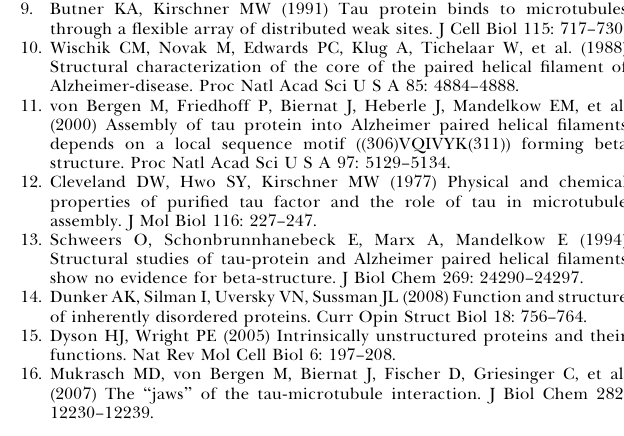
Figure S1. Degeneracy of C a Connectivity (A) Residue Y18 points back to T17, but for 18 other residues the C a frequency also lies within a range of þ / (cid:2) 0.2 ppm (red strip) of the C a (i-1)peak of Y18. (B) Comparison of C a chemical shift degeneracy observed in htau40